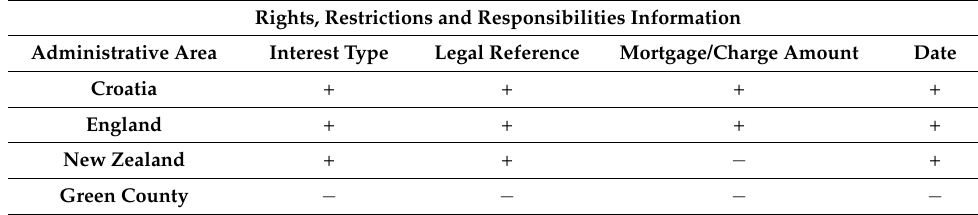
Table 4. Attribute analysis of Register’s Interests